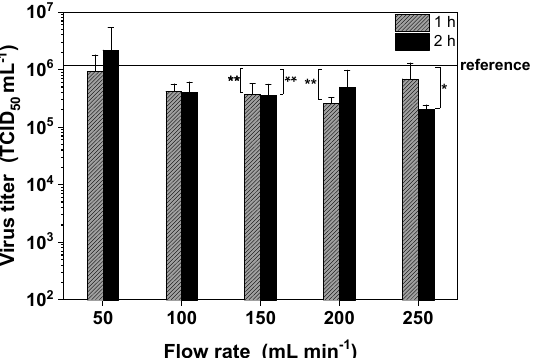
Figure 5. The time-dependent influence of shear stress induced by the peristaltic pump on the infectivity of MV. The virus suspension was pumped in a circle to determine the influence of shear stress caused by the basic downstream processing (DSP) setup. Data are means plus standard deviations of triplicates. The reference is shown as a solid horizontal line (* p ≤ 0.05; ** p < 0.1).